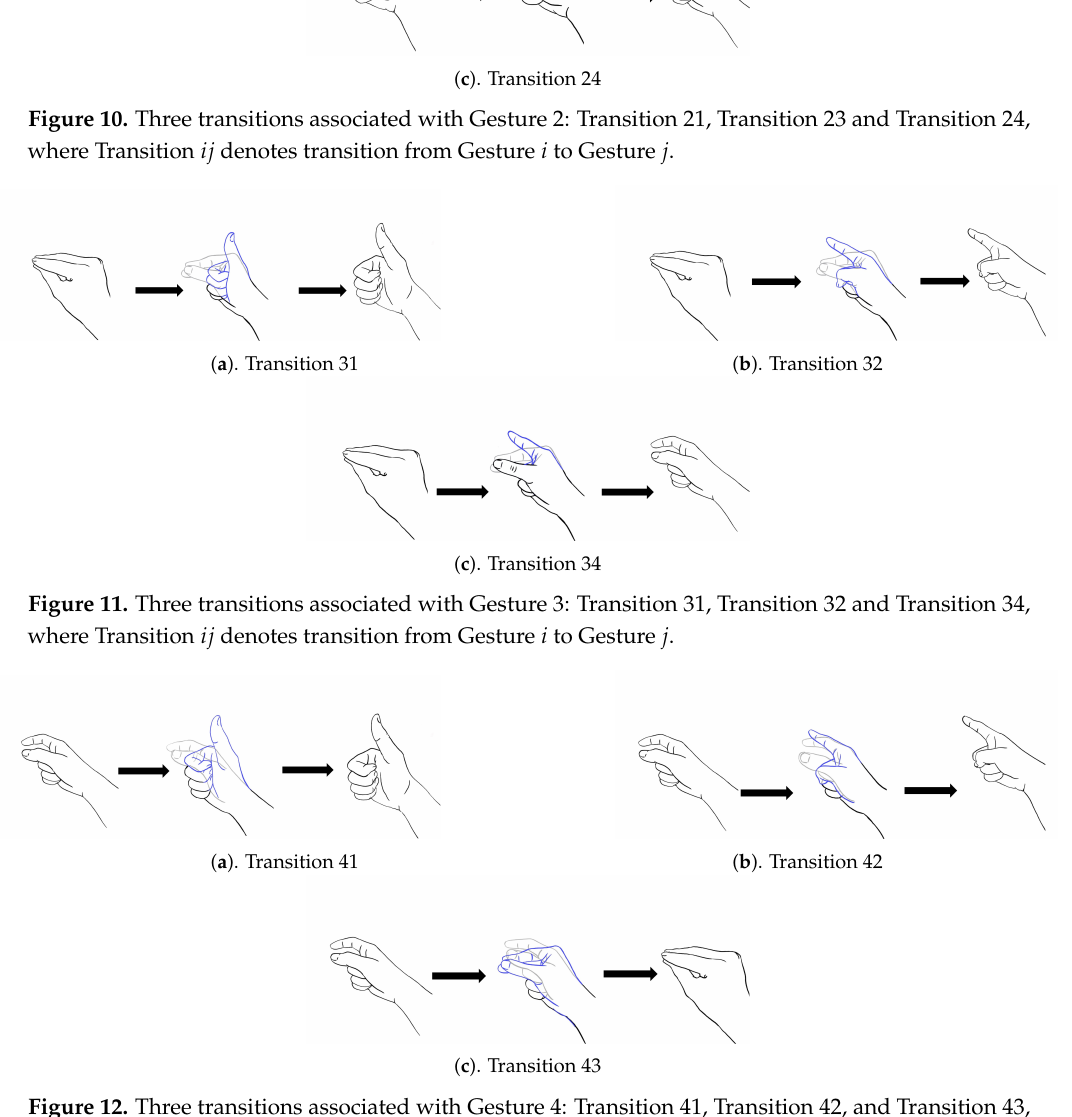
Figure 12. Three transitions associated with Gesture 4: Transition 41, Transition 42, and Transition 43, where Transition ij denotes transition from Gesture i to Gesture j